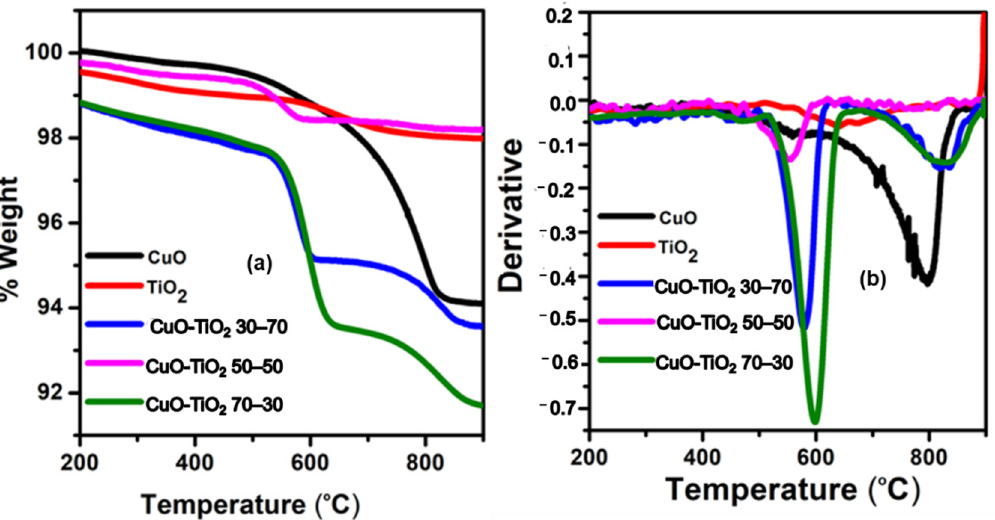
Figure 5. ( a ) TGA diagrams and ( b ) the derivatives diagrams of TiO 2 , CuO, and CuO ‐ TiO 2 (30/70, 50/50, and 70/30).